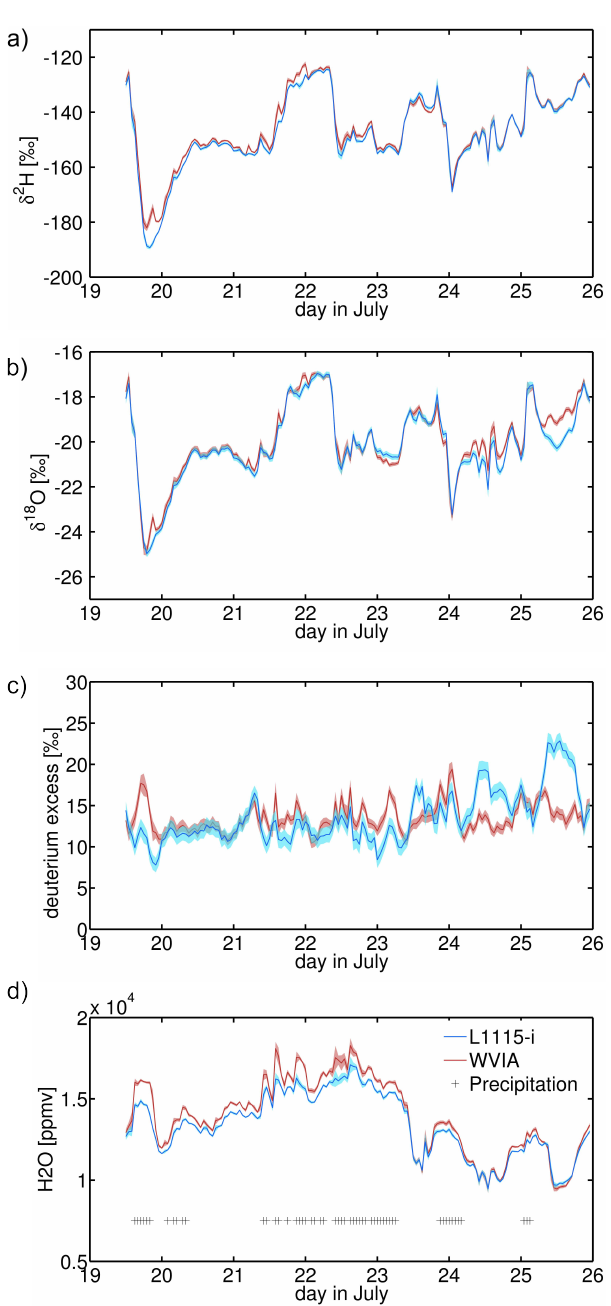
Fig. 13. Time series of δ 2 H (a) , δ 18 O (b) , deuterium excess (c) and water vapour mixing ratio (d) from ambient air measurements in Zurich from 19–26 July 2011 with L1115-i in blue and WVIA in red. The data were averaged to 1h and the shaded area shows the 1h standard deviation based on 5s measured data for L1115-i and 5s averaged data for WVIA. Crosses in (d) indicate the occurrence of